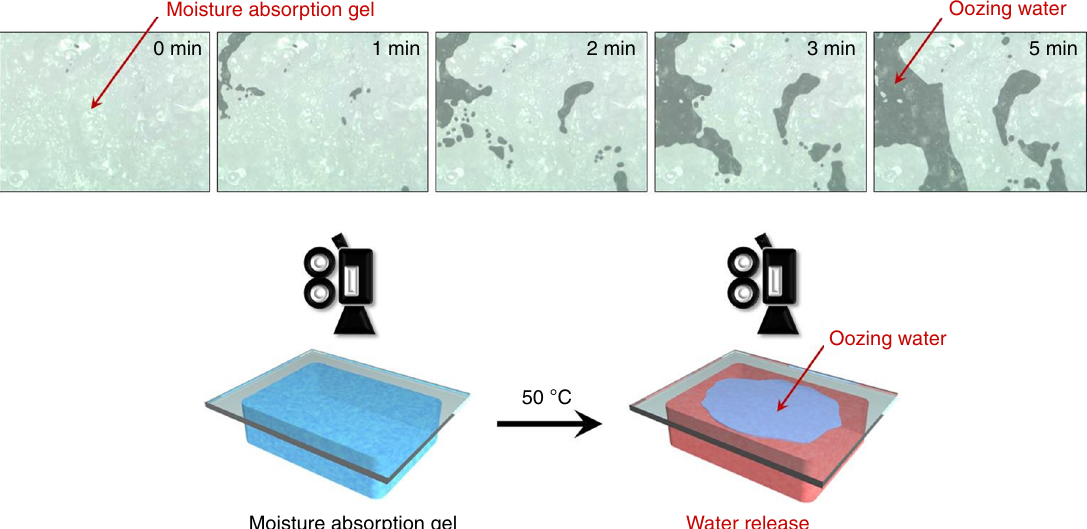
Fig. 3 Images of thermo-responsive water oozing. Images of the water oozing behavior of the PNIPAAm/Alg IPN gel during heating at 50 °C after moisture absorption